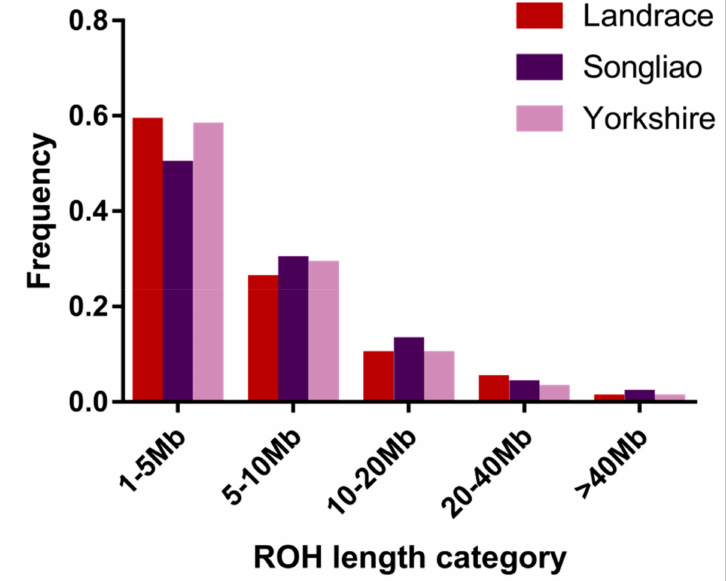
Figure 1. Classification of runs of homozygosity (ROH) in five di ff erent length categories (from 1–5 Mb to more than 40 Mb ) (x-axis) and the frequency of ROH in each category in each breed (y-axis).